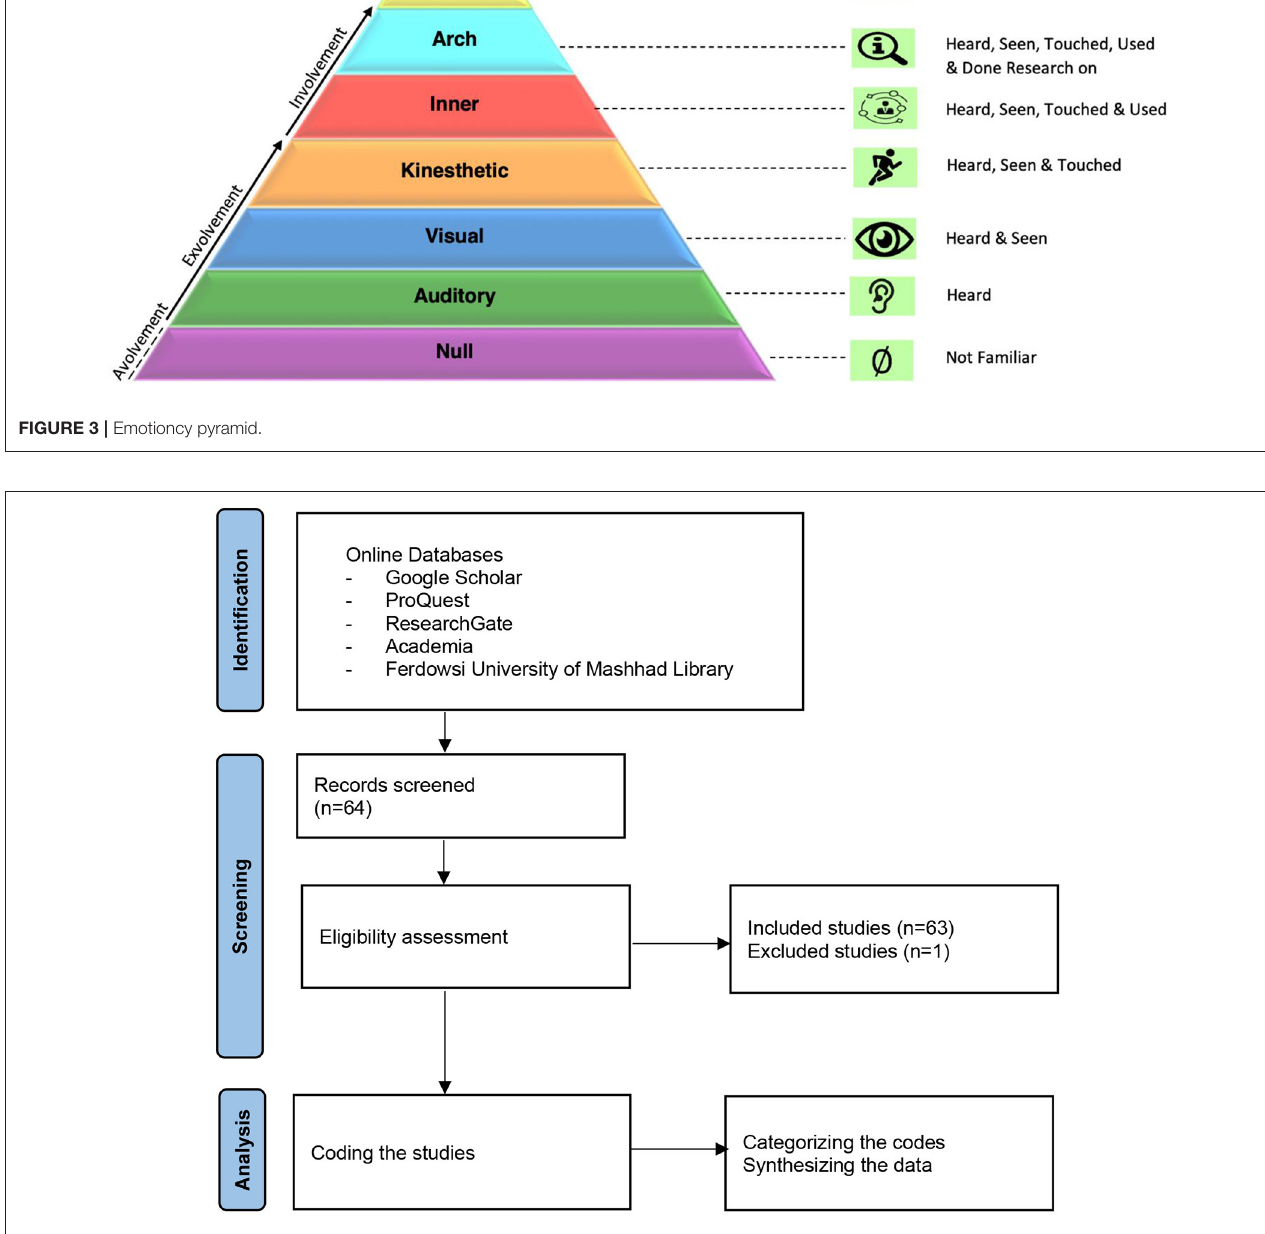
FIGURE 4 | PRISMA flow